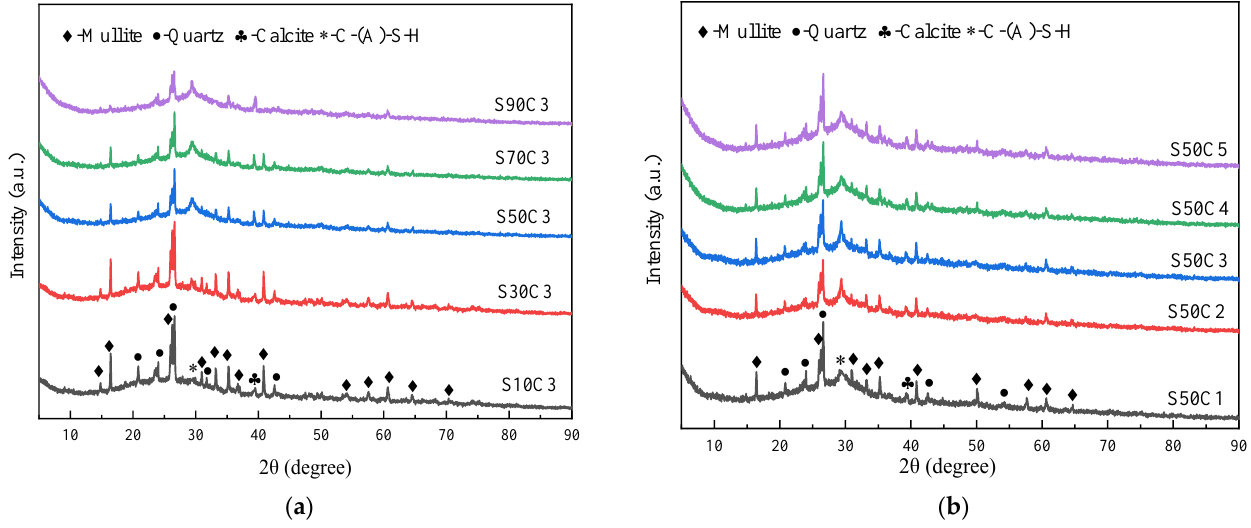
Figure 5. XRD pattern analysis of alkali-activated composite cementitious materials: ( a ) slag content; ( b ) activator concentration. ( b ) activator